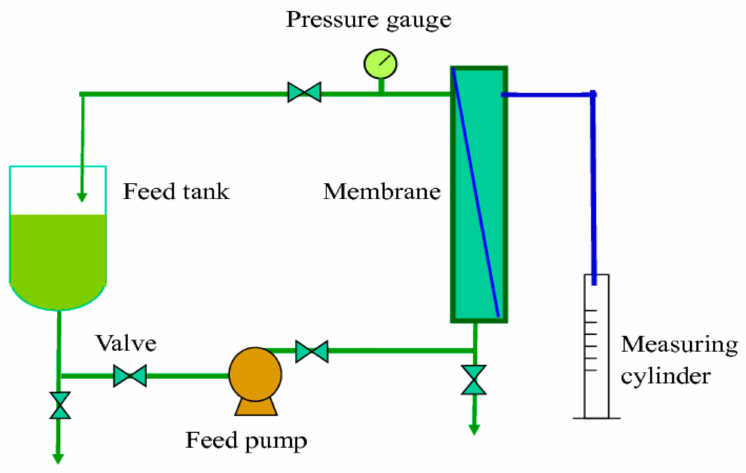
Figure 3. Schematic process of normalized water